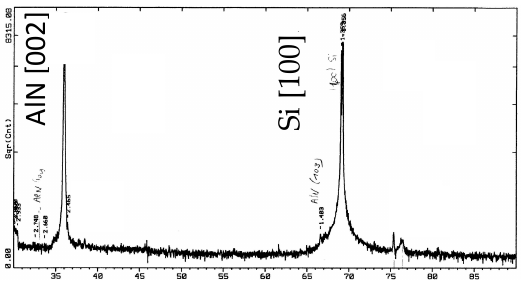
Figure 2. XRD measurement on fabricated AlN films.